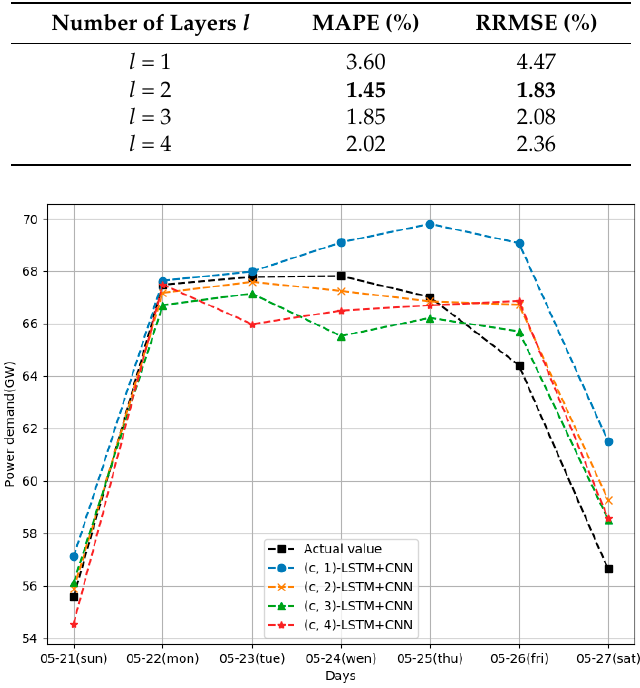
Table 4. Errors by l values for the ( c , l )-LSTM+CNN hybrid forecasting model with d 1 . Number of Layers l